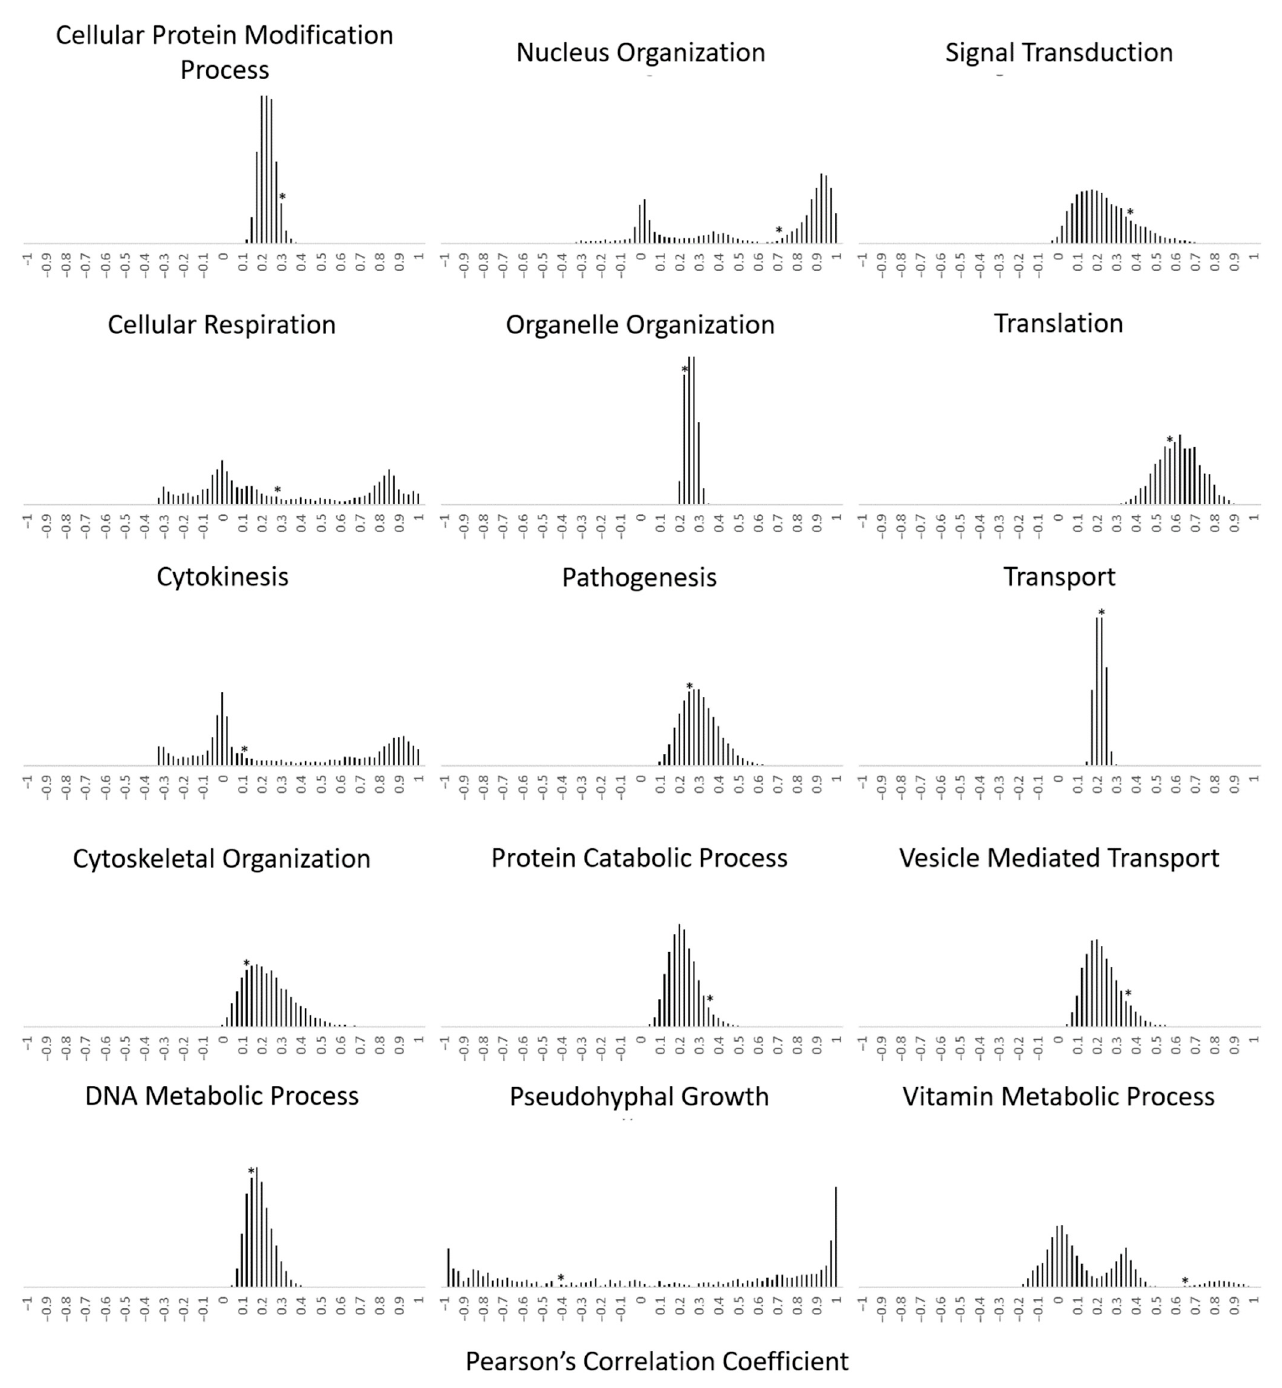
Figure 2. Many functionally clustered gene sets exhibit tighter transcriptional coregulation than random subgroupings of comparable sizes. Shown is the transcriptional correlation for every possible functional clustering arrangement that could have arisen through bootstrapping with replacement. The PCC was calculated for 10,000 iterations that represent every possible combination of clustering that could have evolved (of comparable size to the actual cluster for each set), and the frequency histograms are presented. The actual PCC for the clustered gene set within each family is marked with an asterisk.